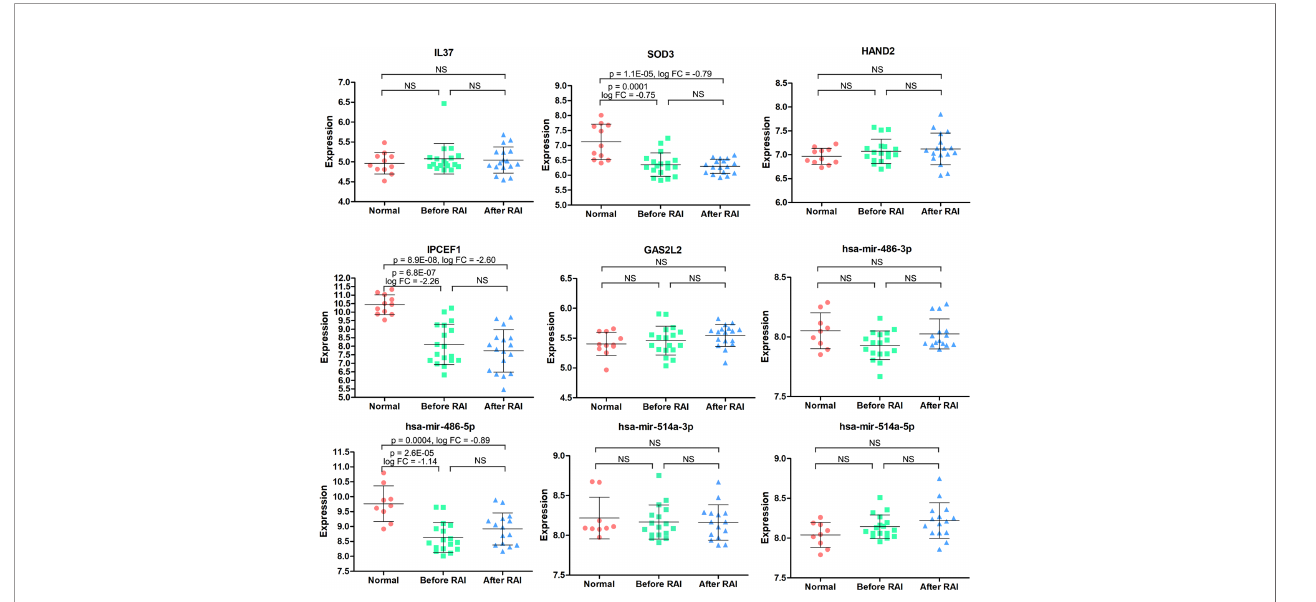
FIGURE 5 | The expression patterns of the 9 candidate RNAs in normal, PTC before RAI, and PTC after RAI groups were validated in the GSE151181. NS, no signi fi